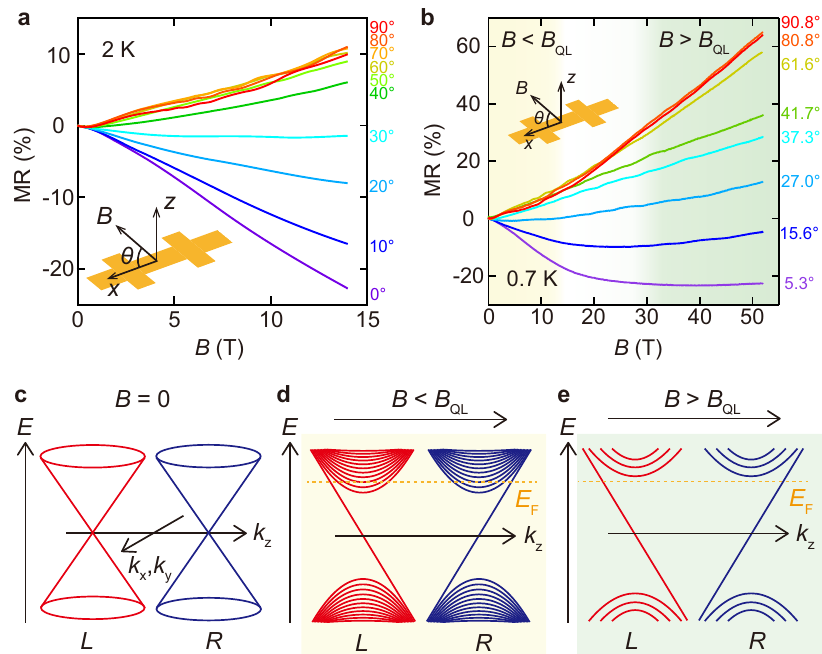
Fig. 3 Angle-dependent magnetotransport for the SrRuO 3 fi lm with t = 10 nm and Landau quantization of a pair of Weyl nodes. a Angular dependence of MR ( ρ xx ( B ) − ρ xx (0 T))/ ρ xx (0 T) for the SrRuO 3 fi lm with t = 10 nm at 2 K, measured by the PPMS up to 14 T. b Angular dependence of MR ( ρ xx ( B ) − ρ xx (0 T))/ ρ xx (0 T) for the SrRuO 3 fi lm with t = 10 nm at 0.7 K, measured by the mid-pulse magnet up to 52 T. c Schematic diagram of a pair of Weyl nodes with opposite chiralities (L and R) with B = 0. d , e Schematic diagram of Landau levels of a pair of Weyl nodes with B < B QL and B > B QL , respectively, where B QL is the magnetic fi eld at which the quantum limit is reached. In b , beige and green areas indicate B < B QL and B > B QL range, (Fig. 3b), con fi rming that the negative MR originates from the chiral anomaly. In the quantum limit (Fig. 3e), the conductivity when B is parallel to I is expressed by